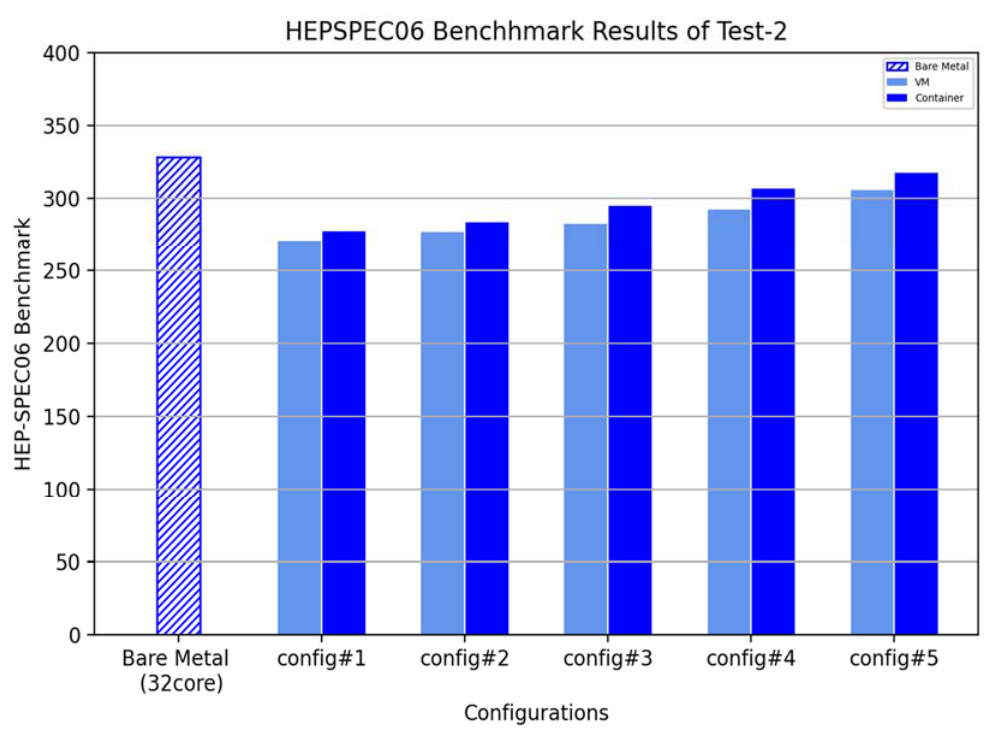
Figure 3. HEPSPEC06 benchmark results for five configurations of test ‐ 2.